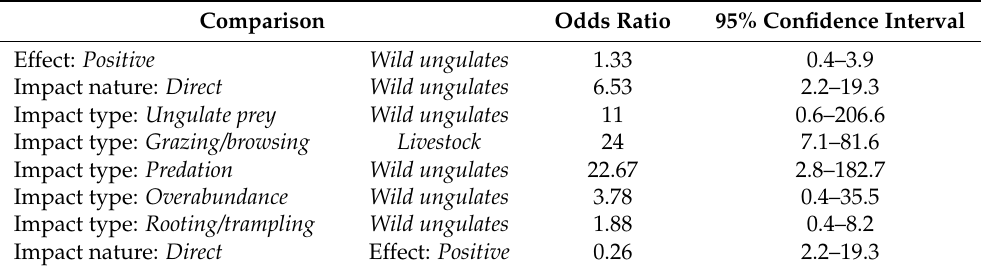
Table 2. Odds ratios and their 95% confidence intervals of the specific combinations of ungulate impact type vs. ungulate species groups (wild ungulates or livestock); the nature (direct or indirect) of ungulate impact vs. positive ungulate